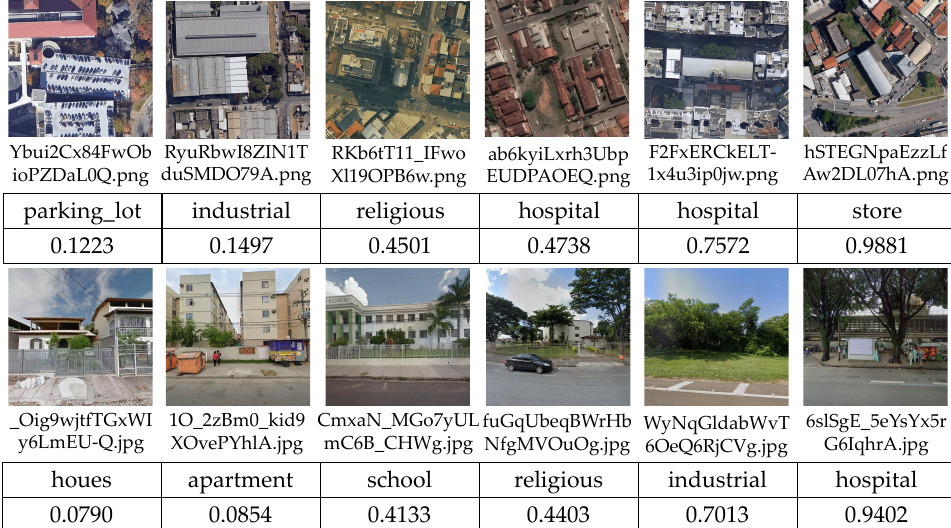
Figure 11. The uncertainty of samples in CV-BrCT computed by the